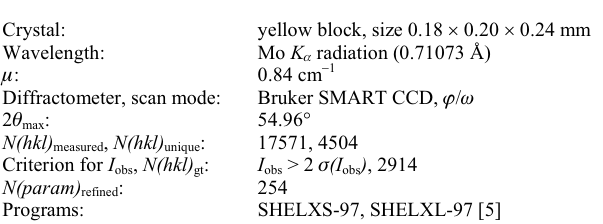
Table 1. Data collection and handling.